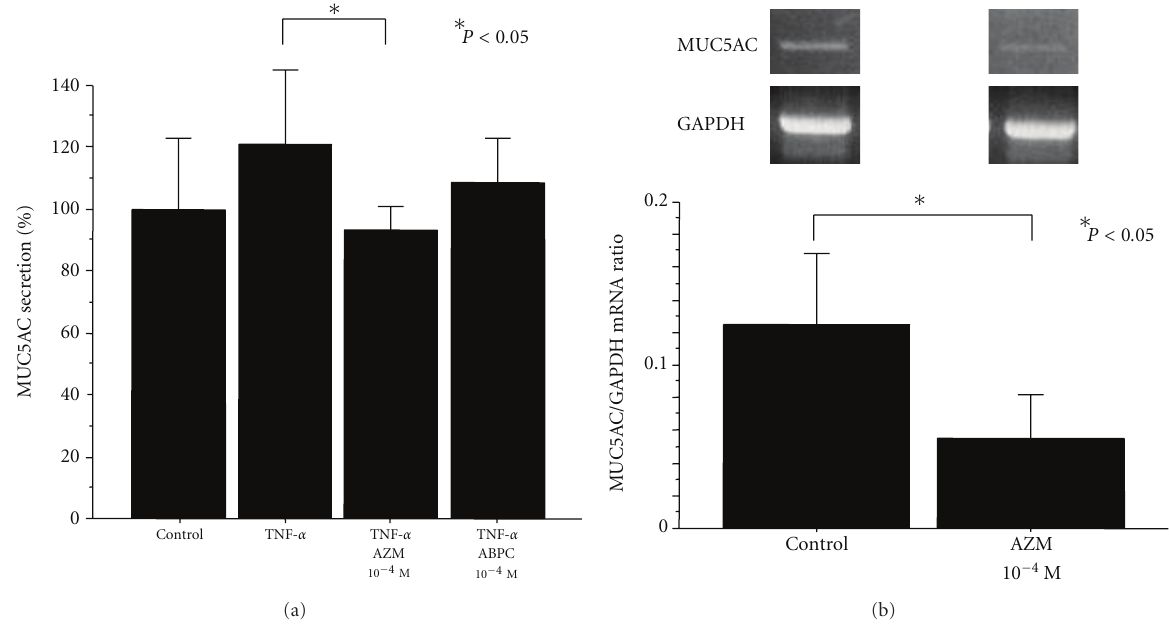
Figure 4: E ff ects of azithromycin (AZM) and ampicillin (ABPC) on TNF- α (20 ng/mL)-induced mucin secretion (a) and MUC5AC mRNA expression (b) from human nasal epithelial cells cultured at air-liquid interface ( n = 5). (a) TNF- α stimulated MUC5AC secretion, and AZM significantly inhibited TNF- α -induced mucin secretion at 10 − 4 M, whereas ABPC showed no e ff ect. (b) Total RNA was isolated and analyzed for MUC5AC and GAPDH mRNA expression by RT-PCR ( n = 5). AZM significantly inhibited MUC5AC mRNA expression at 10 − 4 M as demonstrated by the MUC5AC/GAPDH